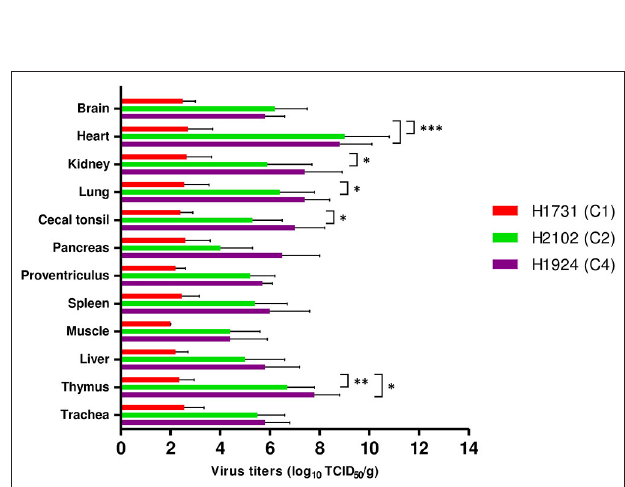
FIGURE 3 | Viral titers in tissues of chickens infected with H1731, H1924, and H2102 virus. Three SPF chickens were intranasally inoculated with 10 6 EID 50 /0.1mL of each virus and euthanized 3 days later. Tissue homogenates were inoculated into DF-1 cells. Viral titers were expressed as median tissue culture infectious dose (TCID 50 ). Data represent mean ± SD. * p < 0.05, ** p < 0.01, *** p < 0.001.